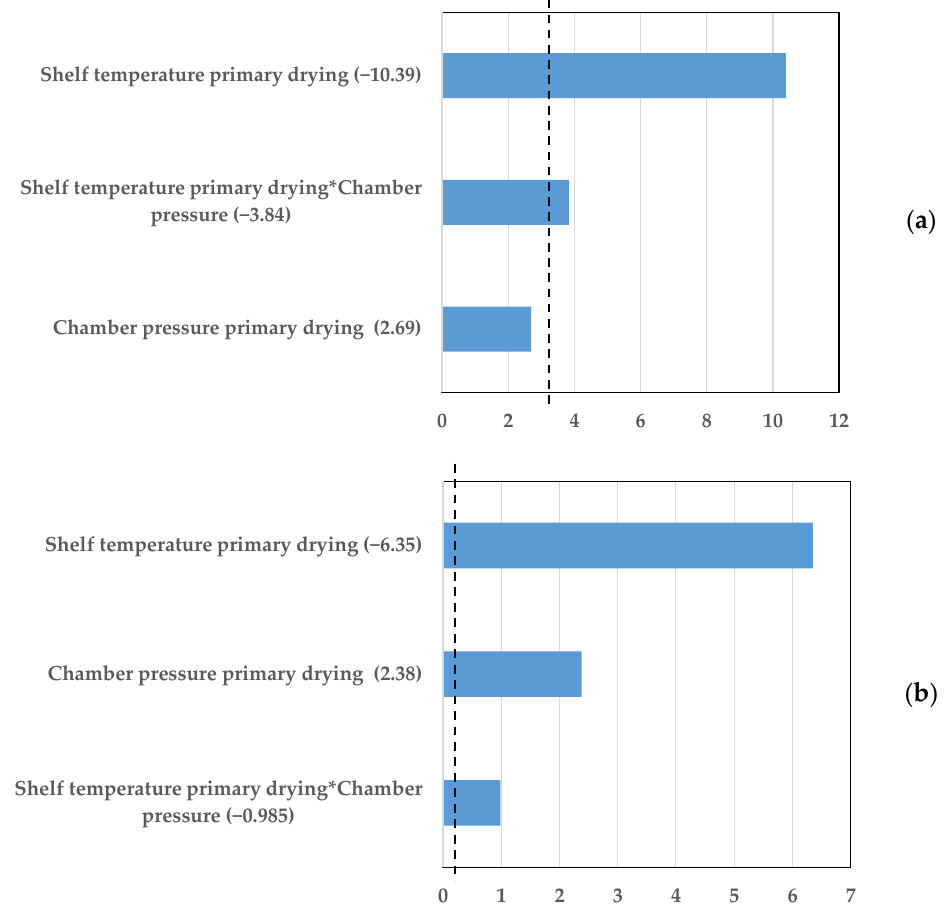
Figure 13. Pareto chart of standardized effects for primary drying endpoint (blue bars: absolute value of t-ratio, black dashed line: significance boundary). ( a ) Experiment. ( b ) Simulation.